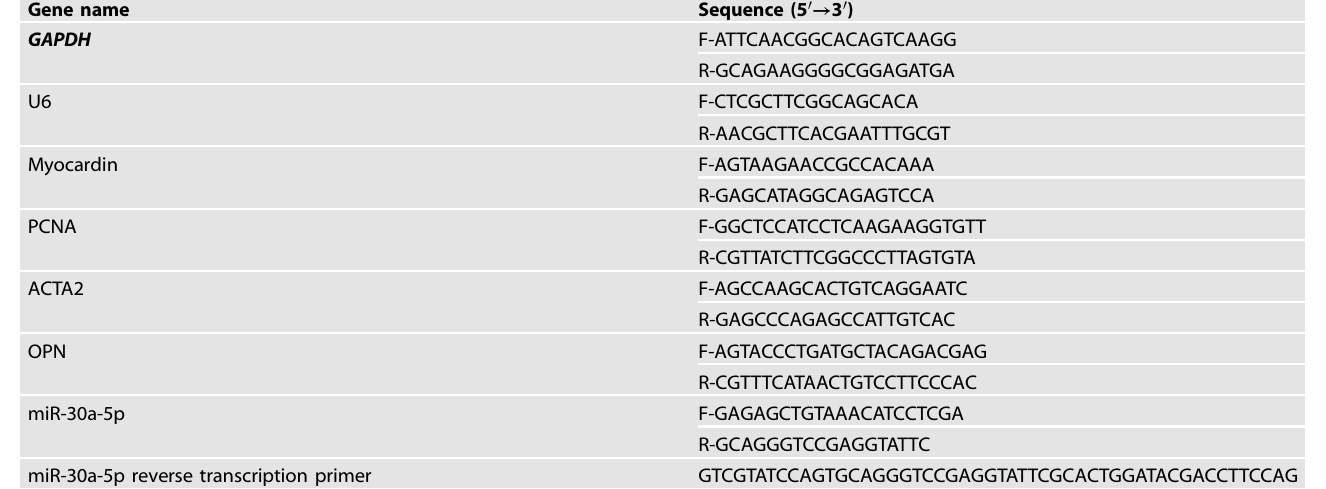
Table 1. The PCR primer